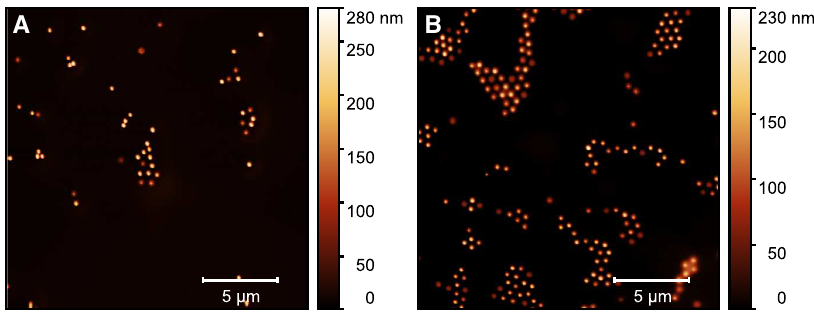
Figure A8. AFM height images (20 × 20 µ m) for the microgel particles loaded with CBD ( A ) and after the release of CBD in water ( B ). The measurements were performed in the dried state at room temperature. The images were used to extract height profiles of the microgel particles using the software